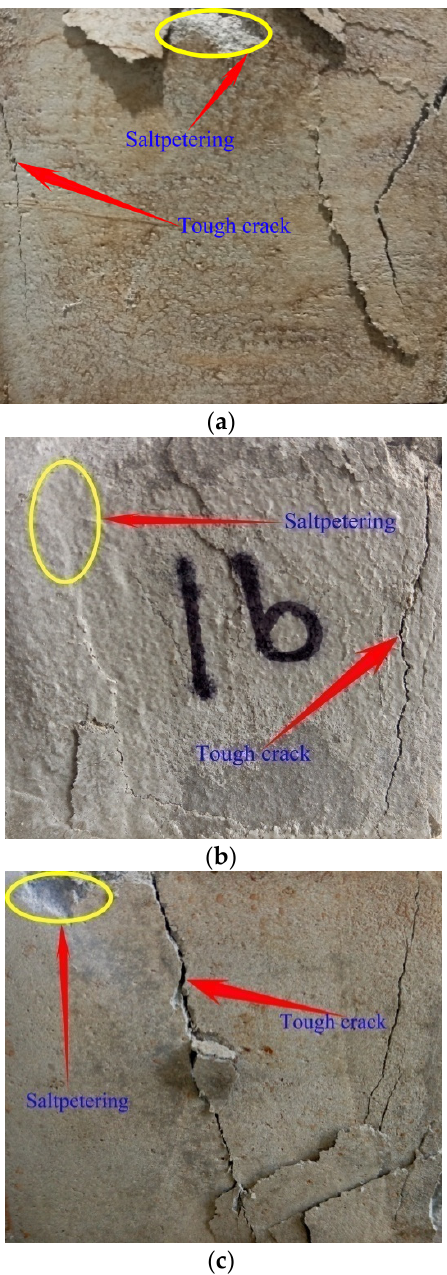
Figure 9. Damaged faces of cubic specimens. ( a ) 10-daysold(maximal width of tough cracks < 1 mm; there lived lower toughness development when the cubic specimen was damaged thoroughly). ( b ) 33-daysold (1 mm <maximal width of tough cracks < 2 mm; the mortar toughness devel- oped certainly when the cubic specimen was damaged thoroughly). ( c ) 91-daysold (2 mm <maxi- mal width of tough cracks < 3 mm; there lived the complete toughness development in the mortar when the cubic specimen was damaged thoroughly).